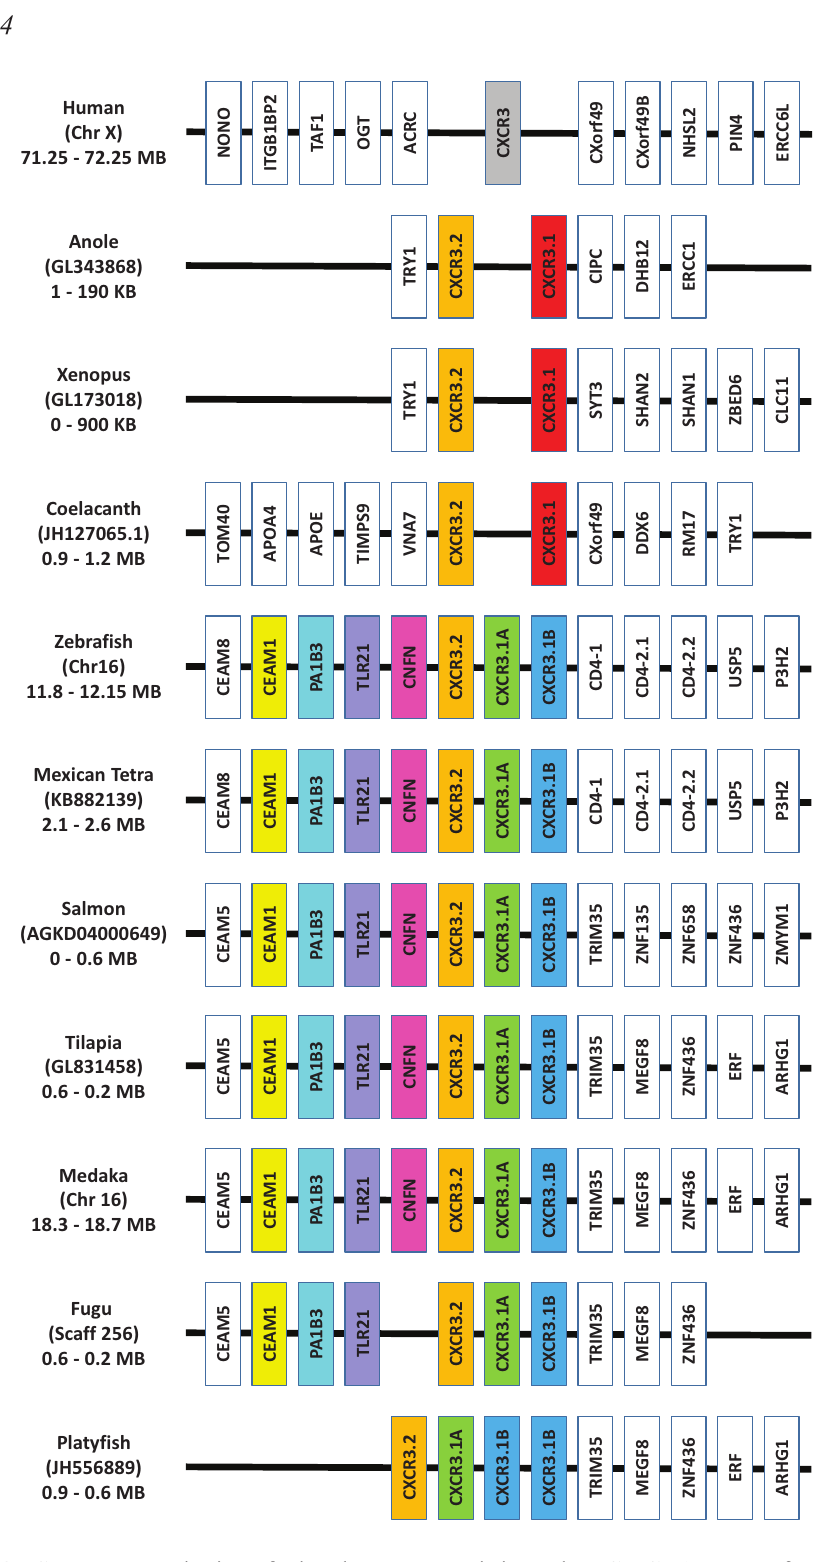
Figure 4. Synteny analysis of the locus containing the CXCR3 gene from human, reptile, amphibian, coelacanth and a selection of teleosts. Genscan [122], BLAST [109] and FASTA [108] were used to analyse the genomes of non-mammalian species to discover the gene order. Three copies of the CXCR3 genes clearly exist in all of the teleost genomes, except platyfish, where four seem to